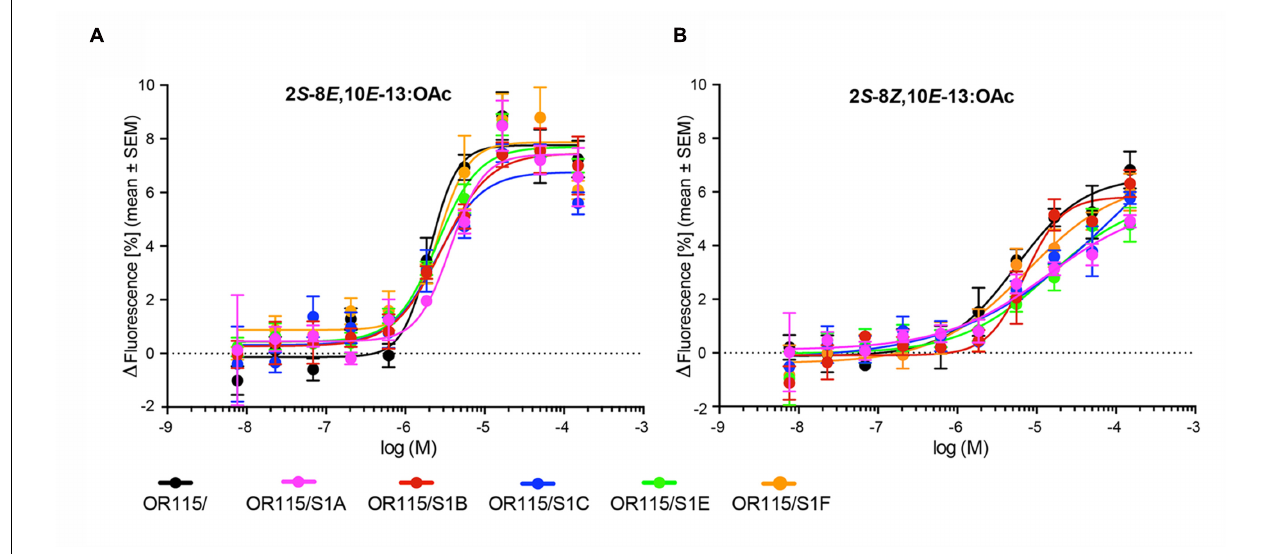
FIGURE 3 | Dose-response curves of six HEK293/TMO/MdesOR115 cell lines, with or without SNMP1 (S1). Means ( ± SEM) are derived from three to four biological replicates ( n = 3–4), each including three technical replicates (i.e., total n = 9–12). (A) Responses to 2 S -8 E ,10 E -13:OAc, and (B) 2 S -8 Z ,10 E